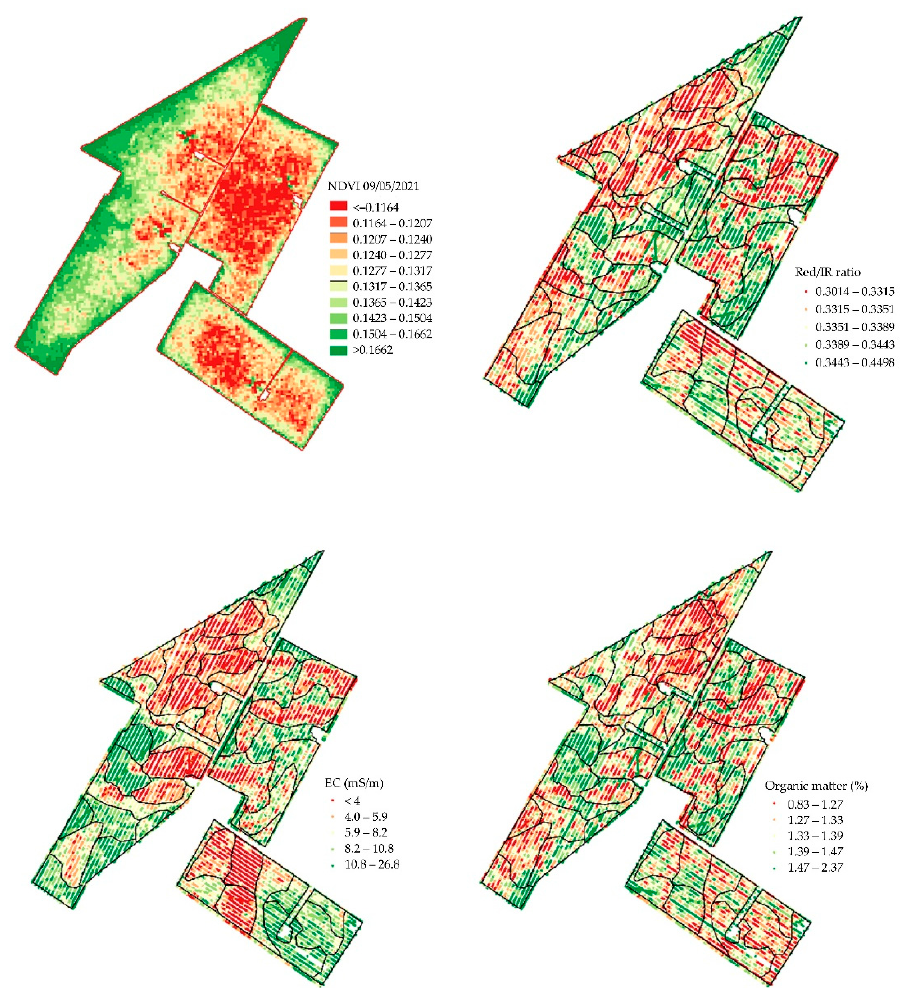
Figure 3. NDVI of bare soil and maps based on soil scanning using Veris ((Salina, KS 67401, USA) machinery (EC, red/IR ratio and estimated organic-matter content).